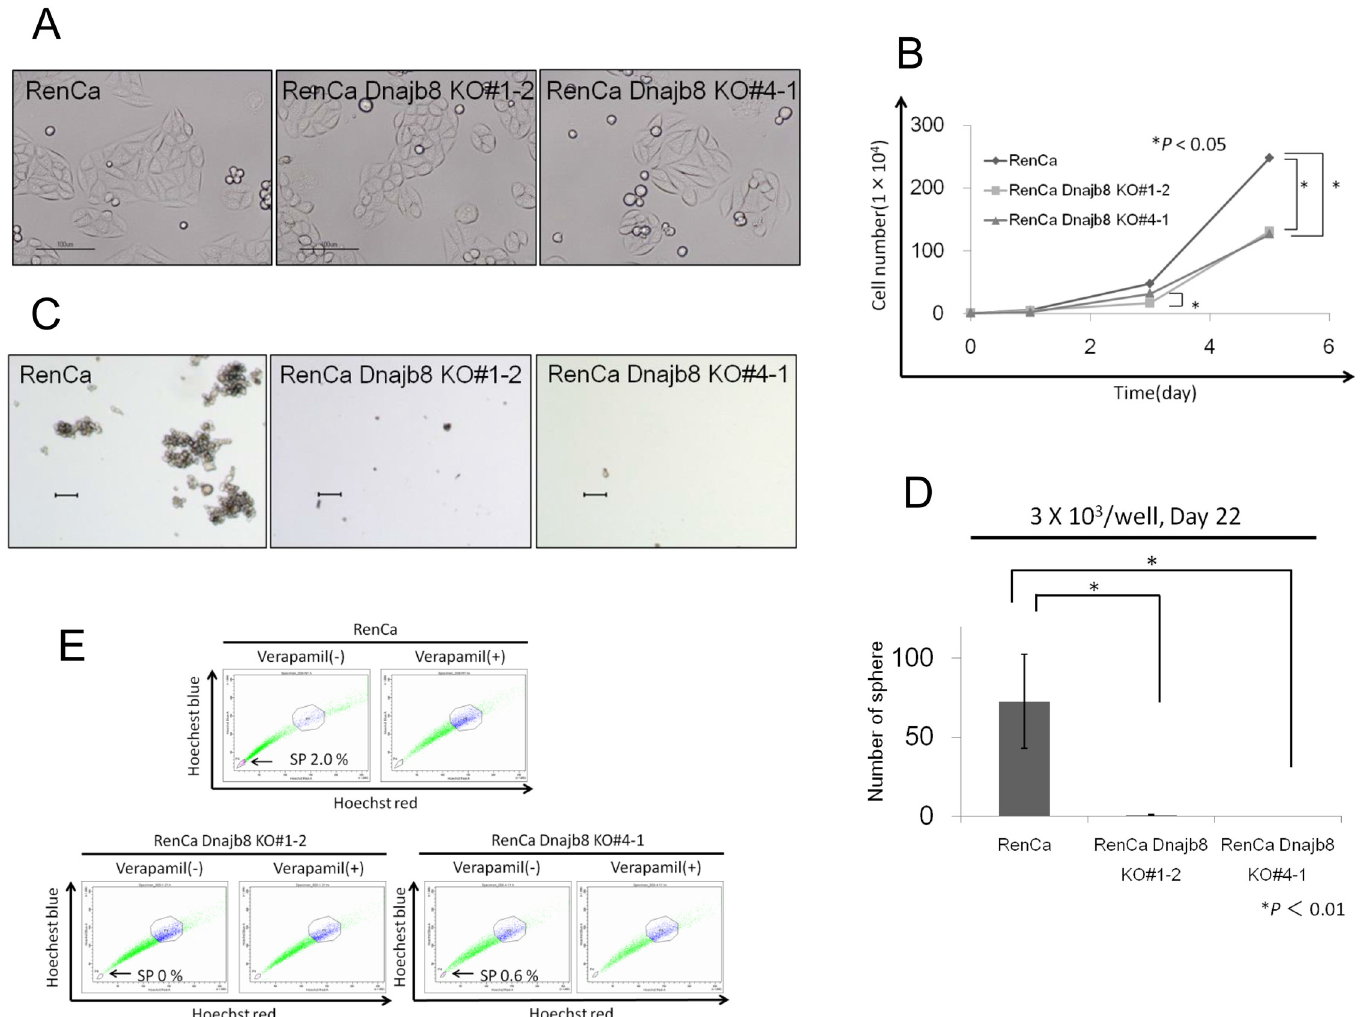
Fig 3. In vitro analysis of Dnajb8 KO cells. (A) Representative images of WT cells and Dnajb8 KO cells. Bars indicate 100 μ m. (B) Cell proliferation assay of WT cells and Dnajb8 KO cells. 10 4 cells were cultured and the number of cells was counted at 1, 3 and 5 days. Data represent means ± SD. The difference between WT cells and two Dnajb8 KO cells was examined for statistical significance using Student ’ s t -test. (C) Representative images of spheres derived from WT cells and Dnajb8 KO cells. Bars indicate 100 μ m. (D) Sphere formation assay. To assay sphere formation efficiency, 10 3 cells were cultured in floating condition for 22 days and the numbers of spheres were counted under a microscope in all fields. (E) Side population (SP) assay. WT cells and Dnajb8 KO cells were stained with Hoechst 33342 dye with or without verapamil and analyzed using a FACSAria II cell sorter.